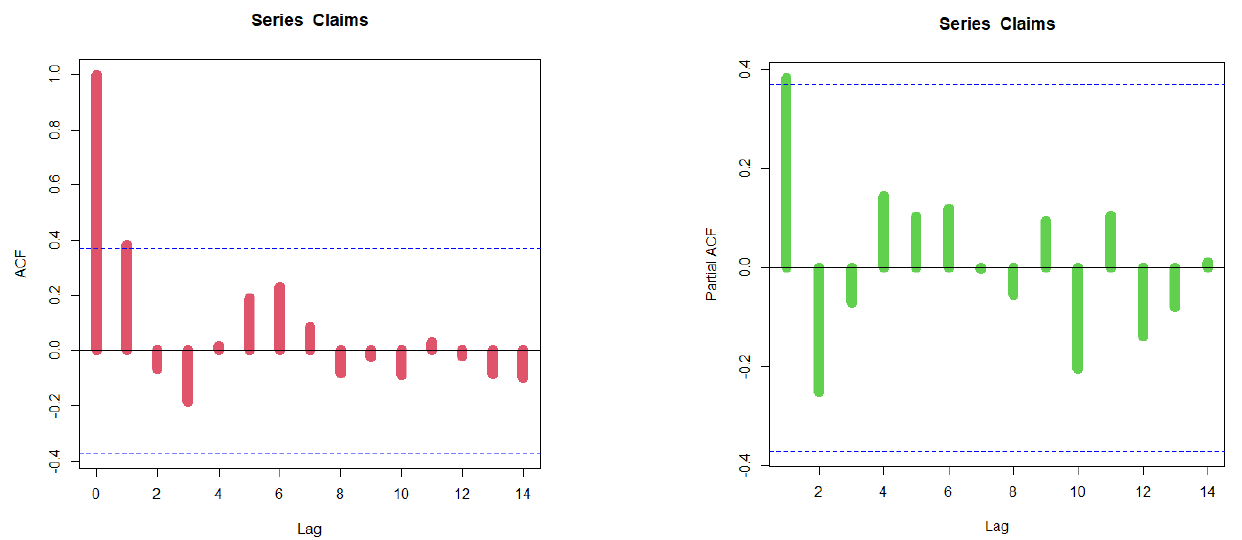
Figure 8. The initial scattergram ( left graph ), the fitted scattergram ( middle graph ), and smoothed scattergram ( right graph ).